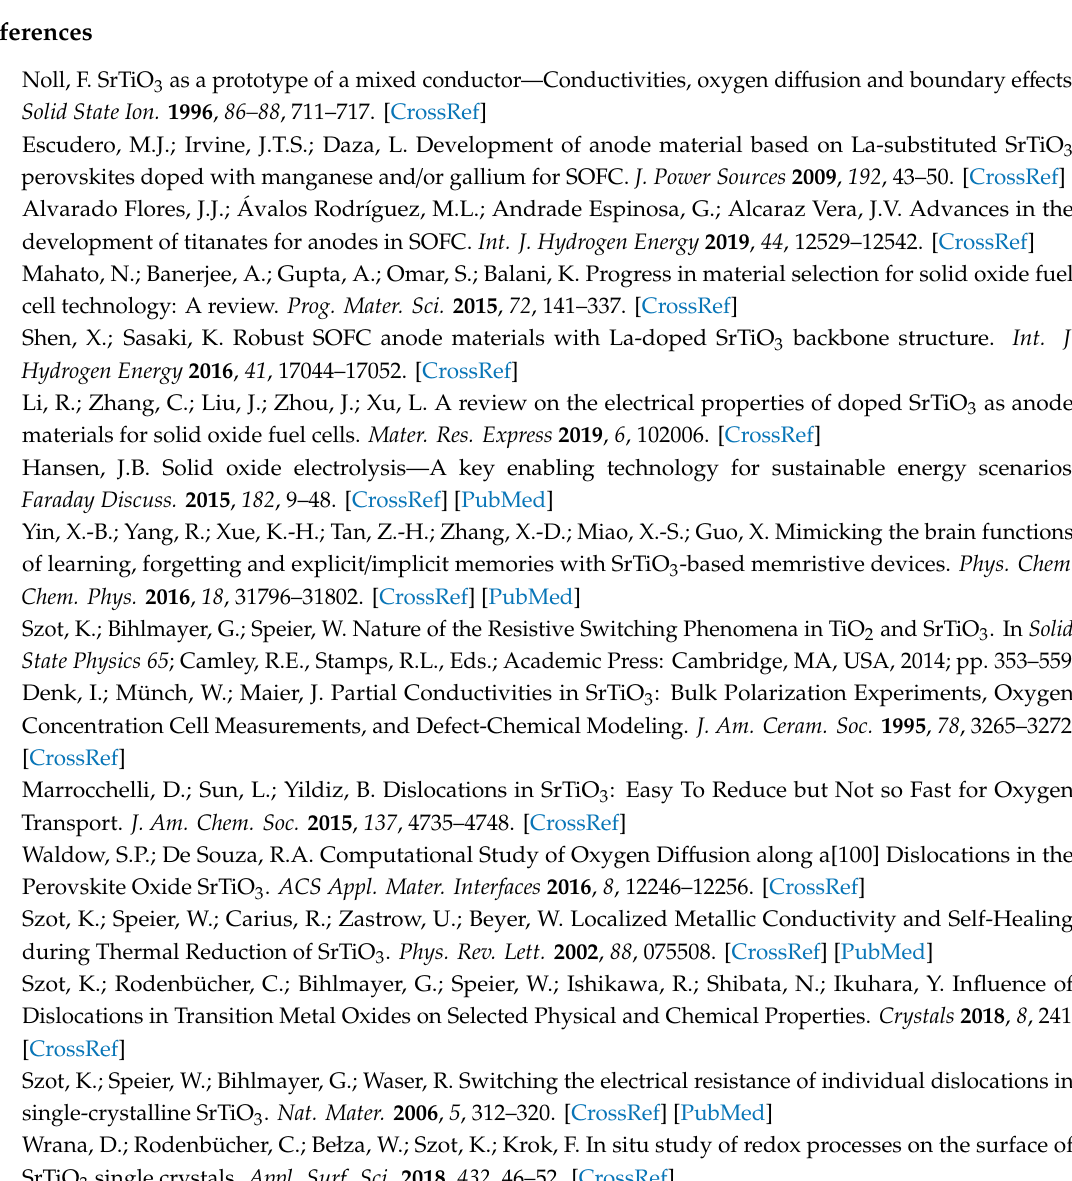
Figure S1: Detailed analysis of the photoluminescence lifetime and intensity measurement on the HF-etched SrTiO 3 surface. The arrows mark the position of selected local minima (orange) and local maxima (blue) of the lifetime. Profiles of lifetime and intensity are plotted for the